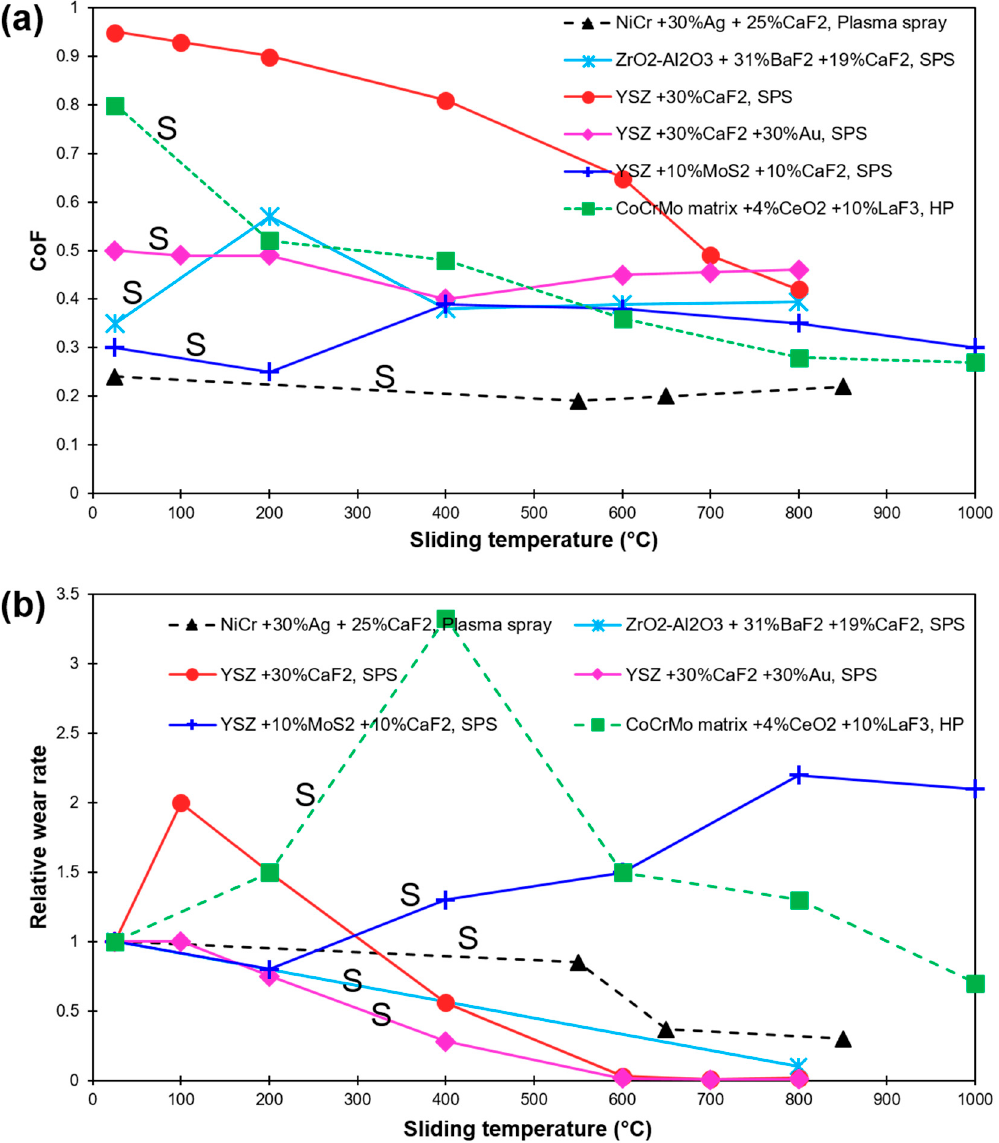
Figure 9. HT sliding results of Fluorides-based composites and coatings as found in recent literature ( a ) CoF; ( b ) Relative wear rate (in relation to their corresponding RT wear). Values are labeled as per Fluorides concentration, matrix material, and fabrication method [10,33,97–99]. Synergic effect of more than one solid lubricant is labeled with S.